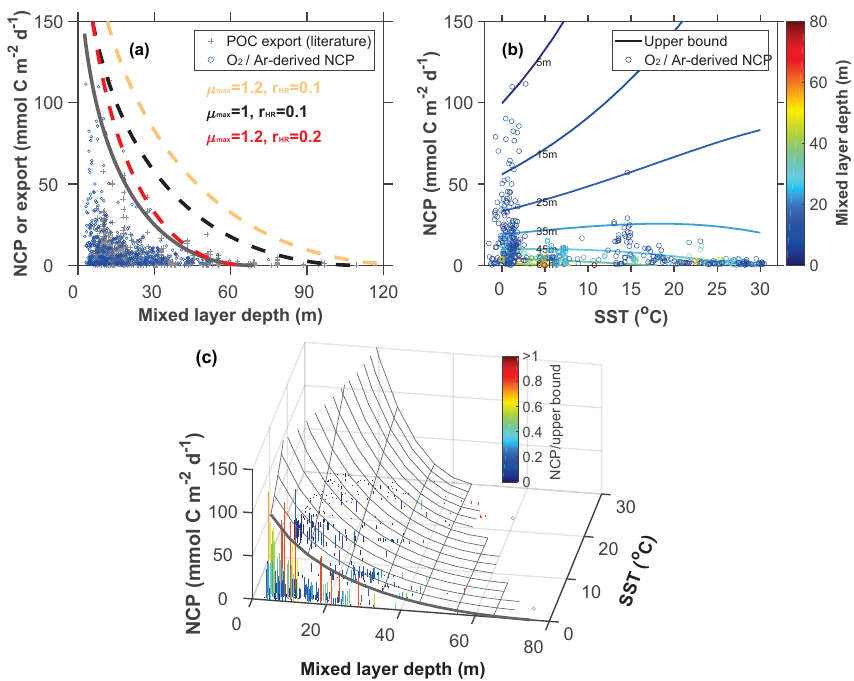
Figure 4. Modeled upper bound on carbon export production compared to field observations as a function of mixed layer depth (MLD) and sea surface temperature (SST). (a) The thick gray line represents the upper bound fitted to the net community production (NCP) data. Dashed lines represent the upper bounds calculated using parameters available in the literature (Table 1). (b) NCP as a function of SST with isopleths of constant upper bounds color coded for MLD. NCP observations are color coded with MLD. (c) Surface representing the envelope of the modeled upper bound of carbon export production as a function of SST and MLD. Bars represent field observations color coded with the ratio of NCP to the upper bound. Observations are based on 234 Th and sediment trap estimates of carbon export production and O 2 /Ar-derived NCP. A stoichiometric ratio of O 2 /C = 1 . 4 was used to convert NCP from O 2 to C units (Laws, 1991). To account for the effect of PAR on export production, both MLD and carbon fluxes are normalized to − log ( 1 − I m ( 0 )) (see Eqs. 19 and 21). The temperature dependence of · e 0 . 08 · T r HR was modeled as r HR = r 0 HR